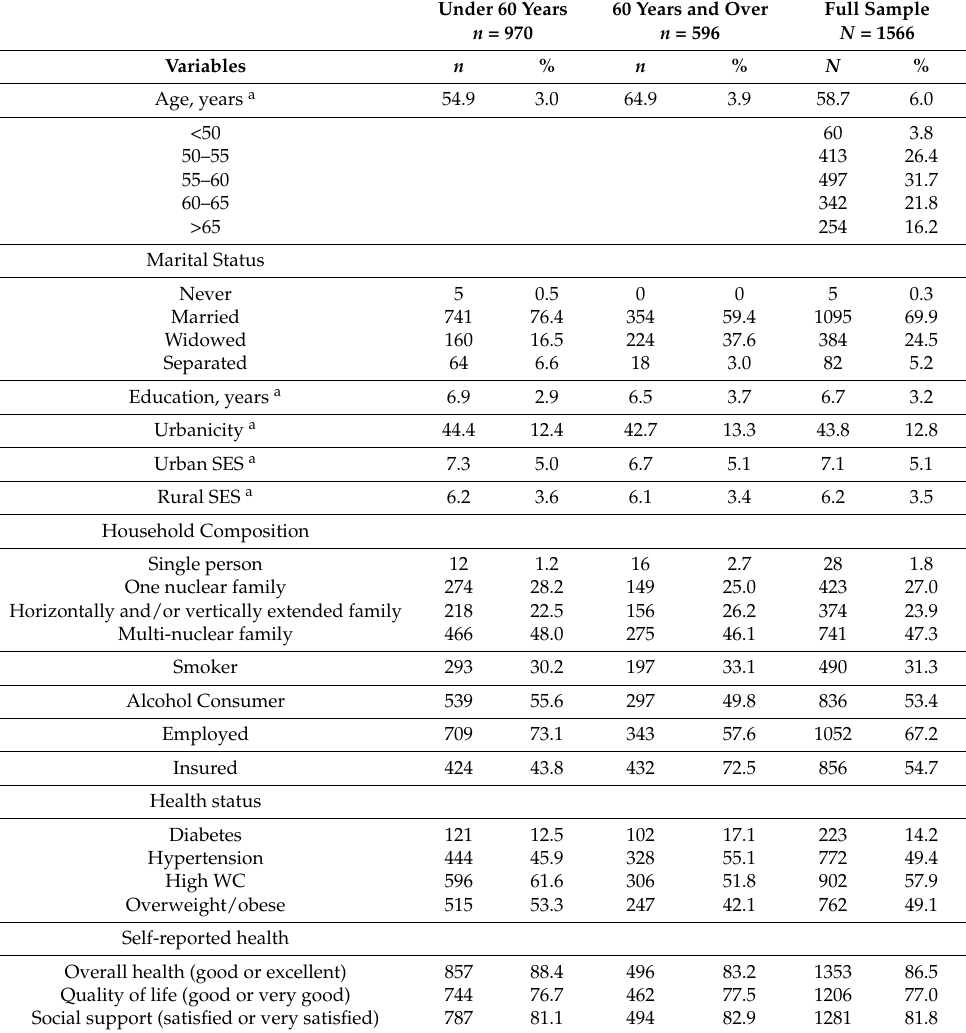
Table 1. Characteristics of the study